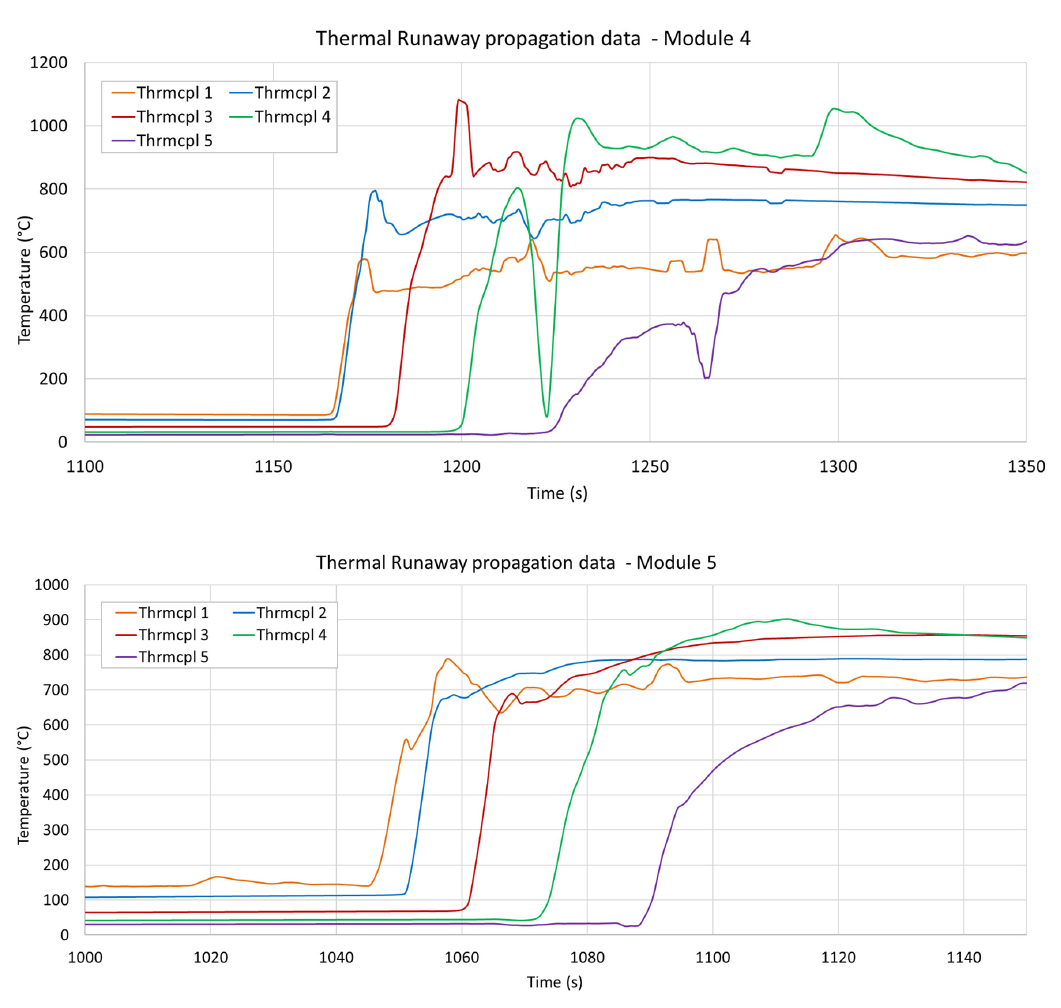
Figure A1. Temperature measurements of modules 2, 3, 4, 5.